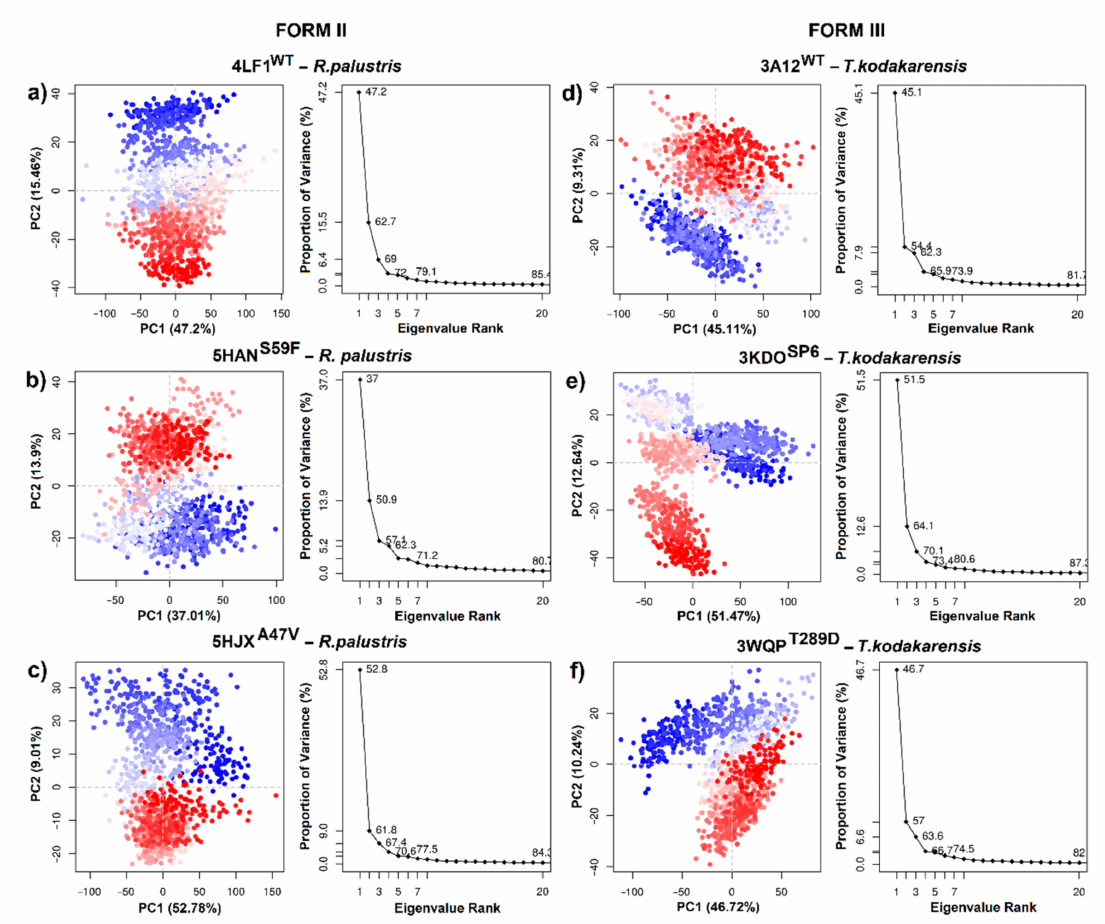
Figure 7. Principal component analysis of RuBisCO isoforms II ( R. palustris ) and III ( T. kodakarensis ). ( a ) 4LF1 WT ( R. palustris ); ( b ) 5HAN S59F ( R. palustris mutant); ( c ) 5HJX A47V ( R. palustris mutant); ( d ) 3A12 WT ( T. kodakarensis ); ( e ) 3KDO SP6 ( T. kodakarensis mutant); and ( f ) 3WQP T289D ( T. kodakarensis